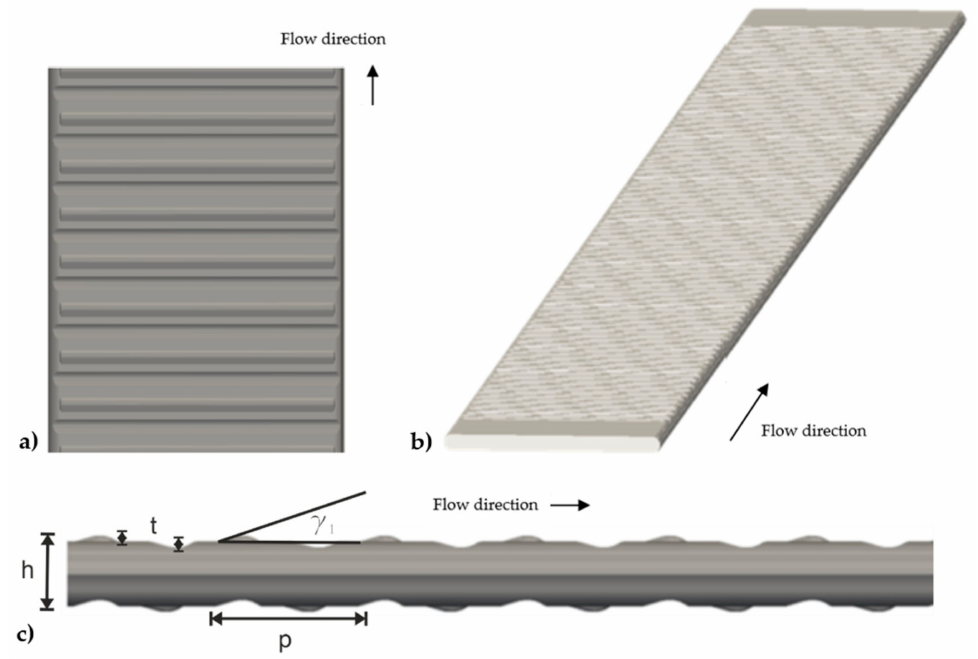
Figure 8. Entire flat tube ( a ) and parts of the flat tube with wave-shapes bumps in top ( b ) and side view ( c